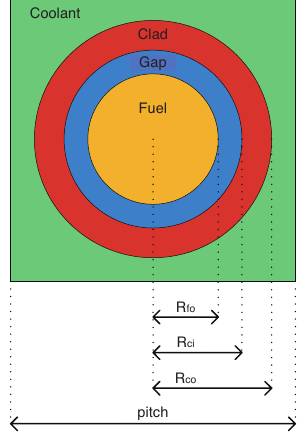
Figure 2. Schematic cross-section of a fuel